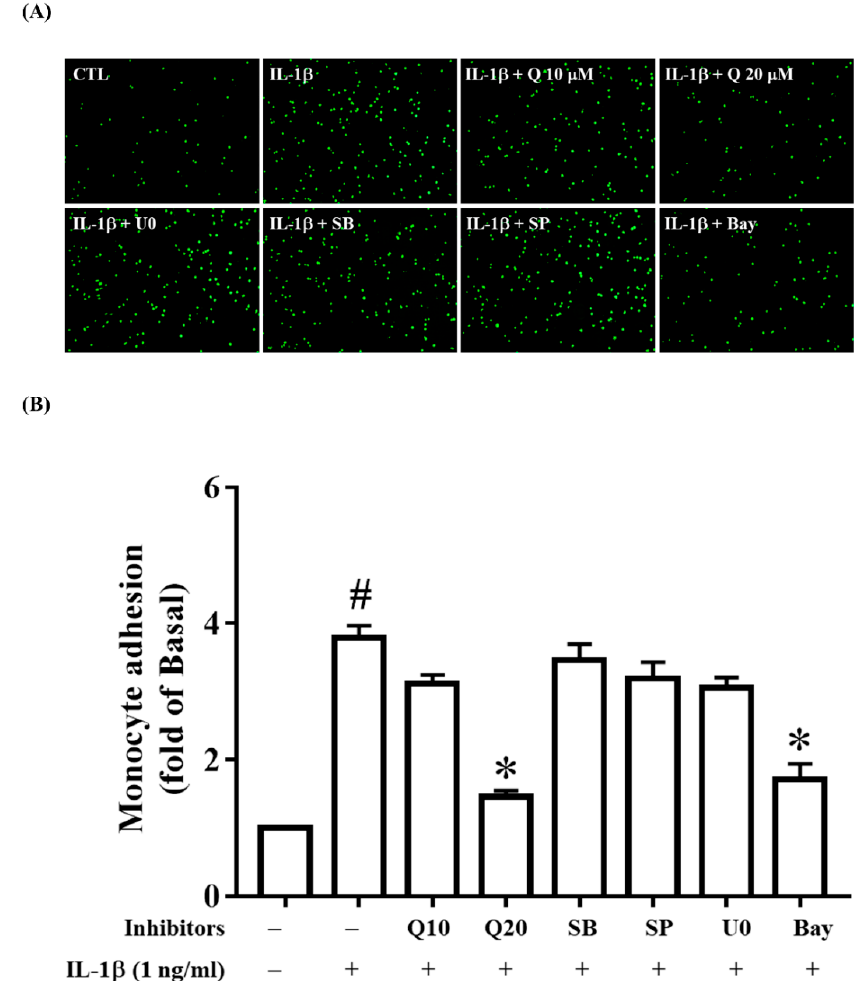
Figure 9. Quercetin significantly suppresses THP-1 cell adherence to IL-1 β -stimulated ARPE-19 cells. ARPE-19 cells were preincubated with quercetin (10, 20 µ M), 10 µ M U0126, 10 µ M SB202190, 10 µ M SP600125 or 5 µ M Bay 11-7082 for 1 h and then stimulated with 1 ng / mL IL-1 β for 24 h. ( A , B ) A THP-1 monocyte adhesion assay was used to evaluate the physiological function of ICAM-1. The fluorescence intensity represents THP-1 cell adhesion to IL-1 β -stimulated ARPE-19 cells, which was quantified using Image J software. The data are expressed as mean ± SD of three independent experiments. # p < 0.05 versus control cells. * p < 0.05 versus IL-1 β -stimulated